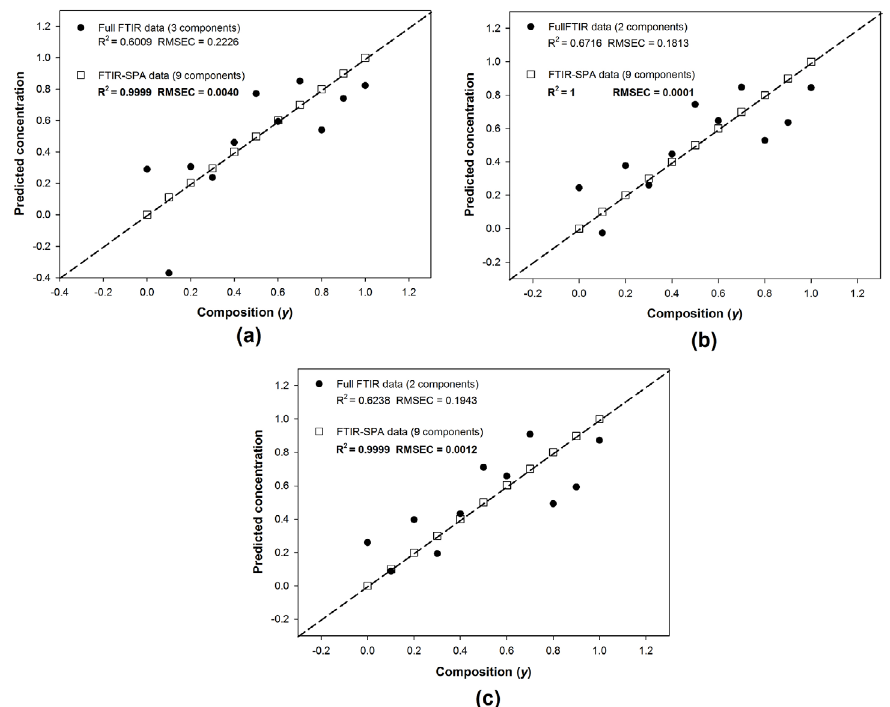
Figure 5. FTIR results. Generalized correlation for the calibration samples after applying the PLS with mean-centered preprocessing and full LOOCV. a) No derivative mode. b) First-derivative mode. c) Second- derivative